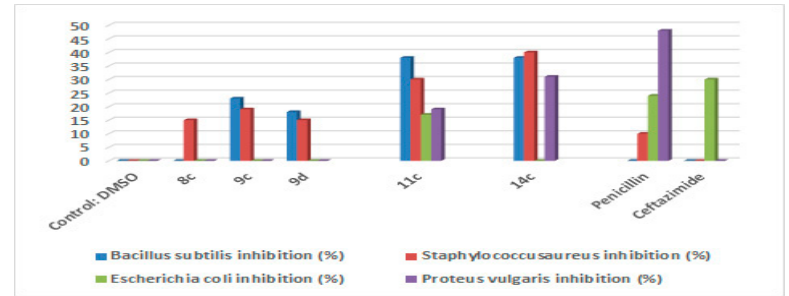
Figure 1. Antimicrobial activity of the active synthesized compounds.